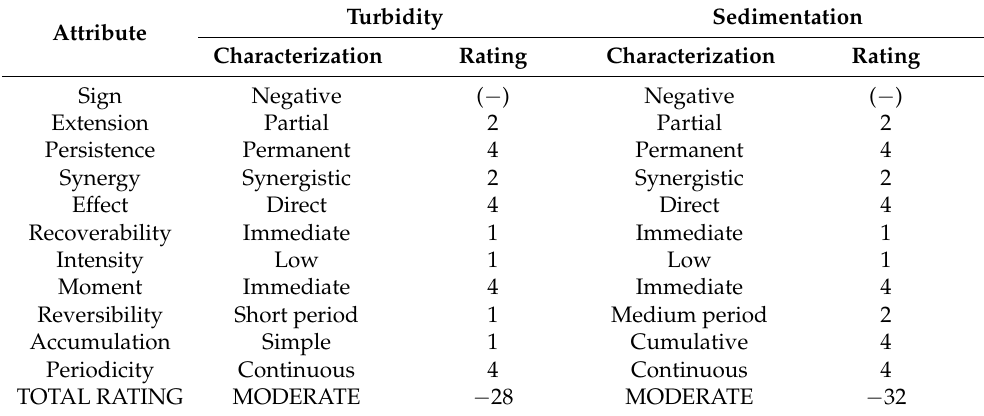
Table 3. Overall assessment of the impact on turbidity and sedimentation during the operation phase. Turbidity Sedimentation Attribute Characterization Rating Characterization Rating Sign